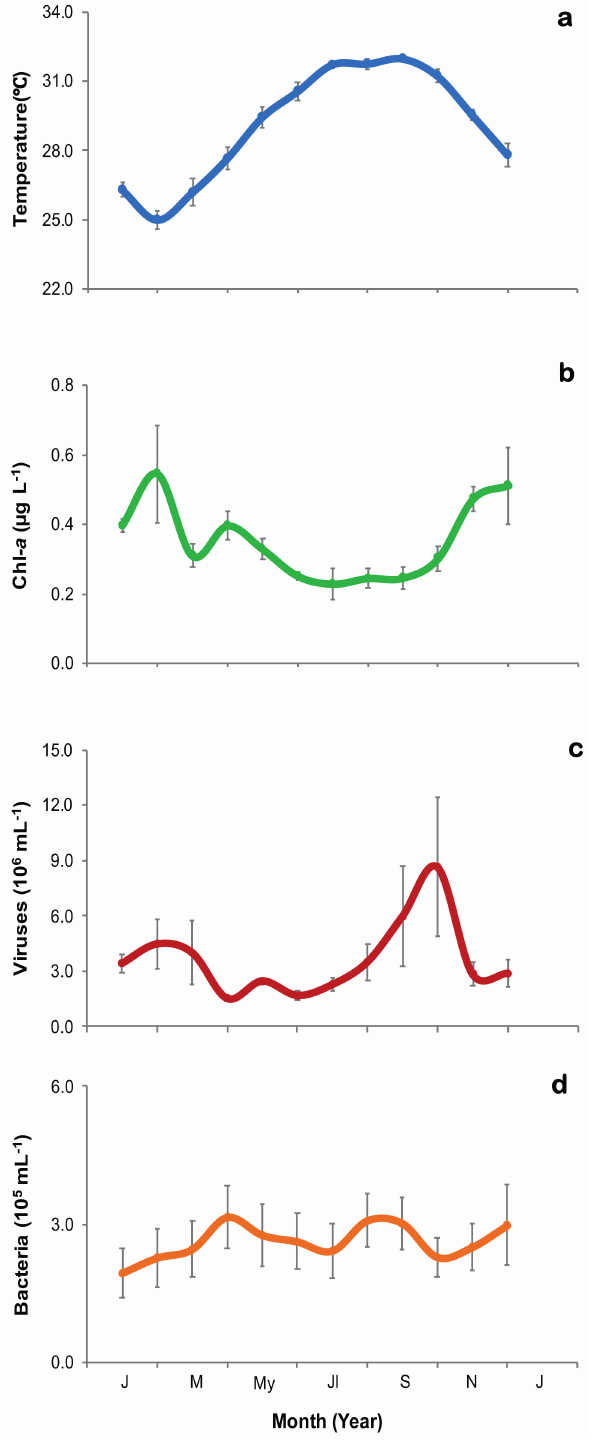
Figure 2. Monthly averaged ( ± SE) environmental parameters during the time-series sampling in the Red Sea from all the sampling events from 2016 to 2018. ( a ) Surface water temperature (blue line and dots), ( b ) Chl- a concentration (green line and dots), ( c ) Viral abundance (red line and dots), and ( d ) heterotrophic bacterial abundance (orange line and